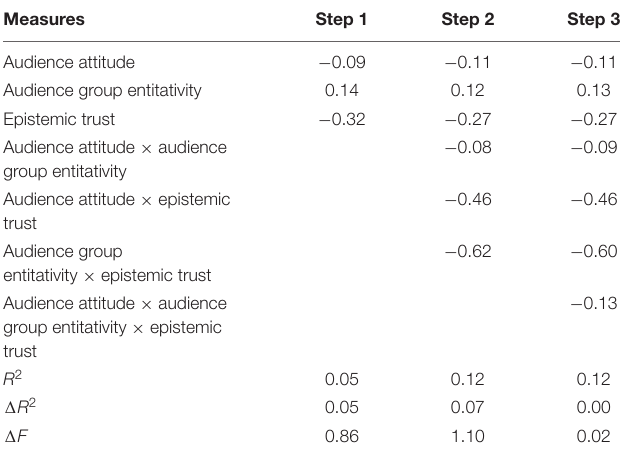
TABLE 2 | Moderated multiple regression analysis with recall valence as a function of audience attitude, audience group entitativity, and epistemic trust (non-standardized regression coefficient).